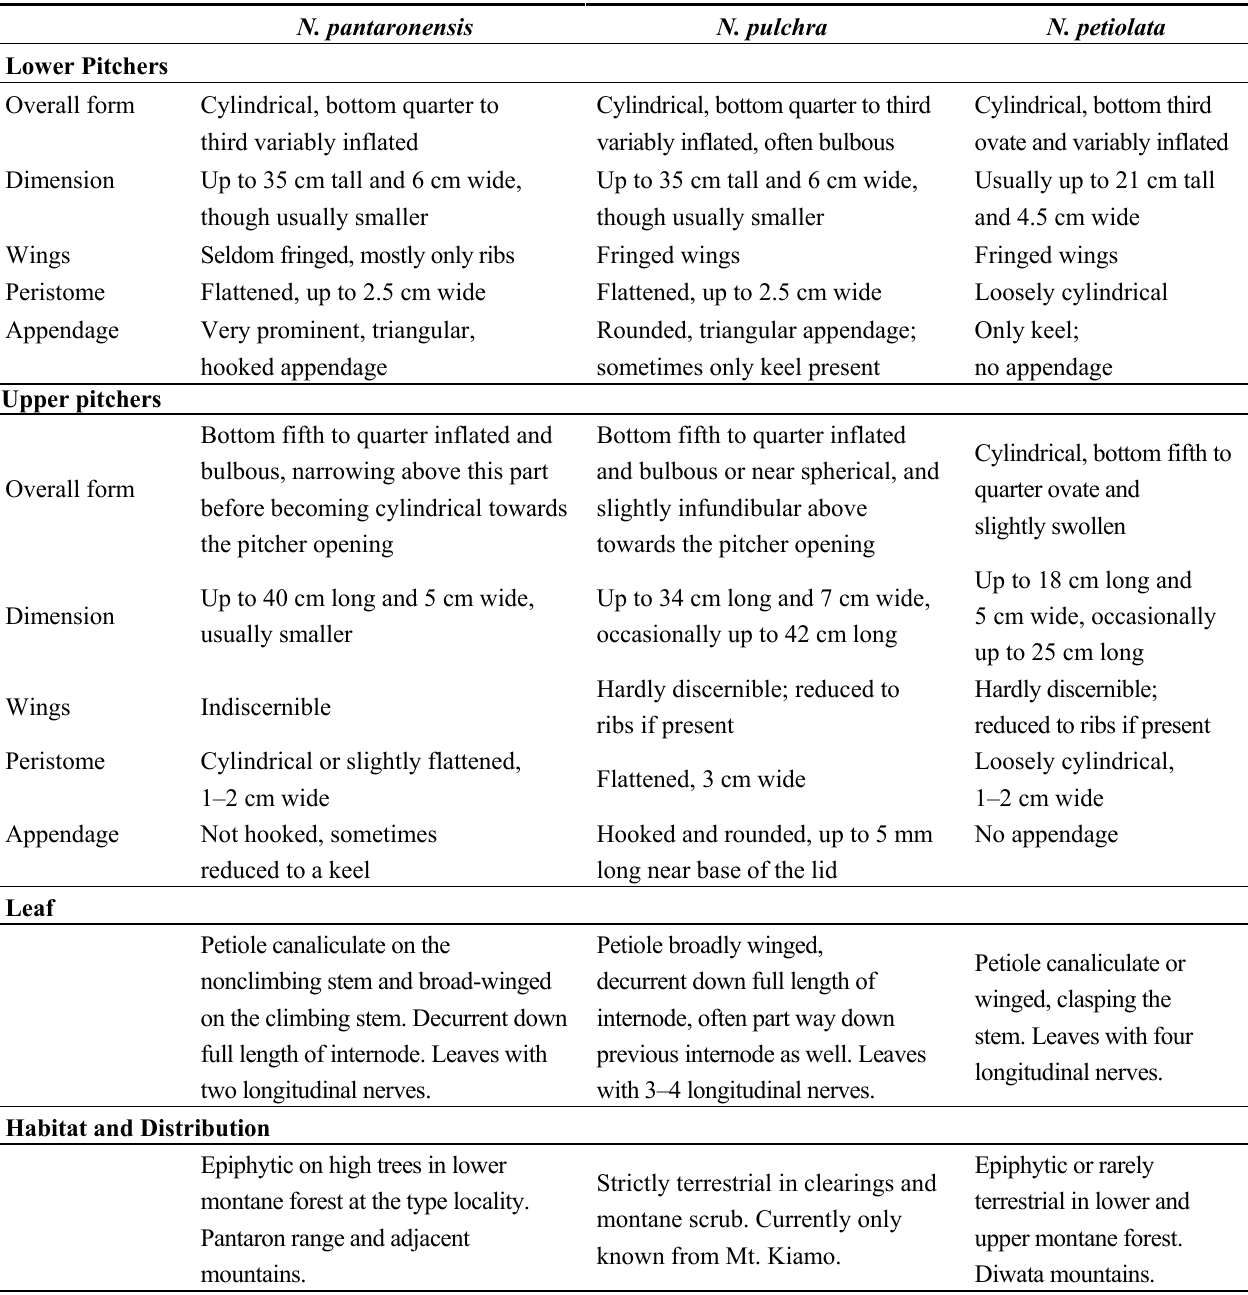
Table 1. The main morphological differences between N. pantaronensis , N. pulchra and N. petiolata (data from